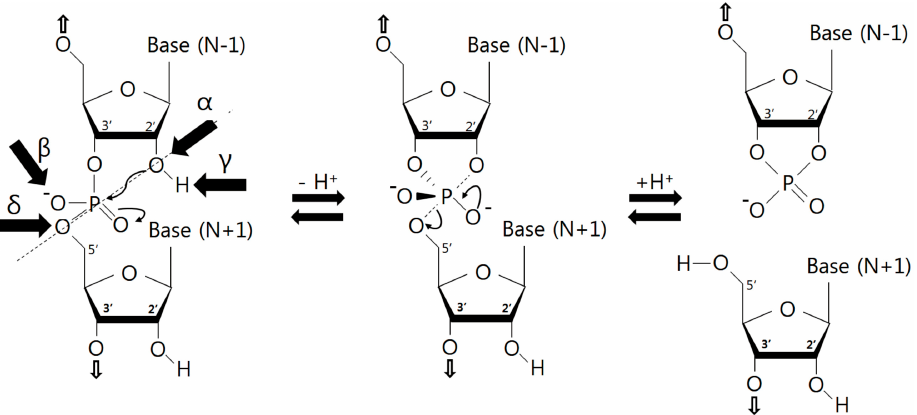
Figure 4. Internal phosphoester transfer mechanism for RNA cleavage. The 2 ′ oxygen nucleophile of a sugar attacks its adjacent phosphorus atom, together with subsequent protonation and departure of the 5 ′ oxygen of a sugar. the 5 (cid:48) oxygen of a